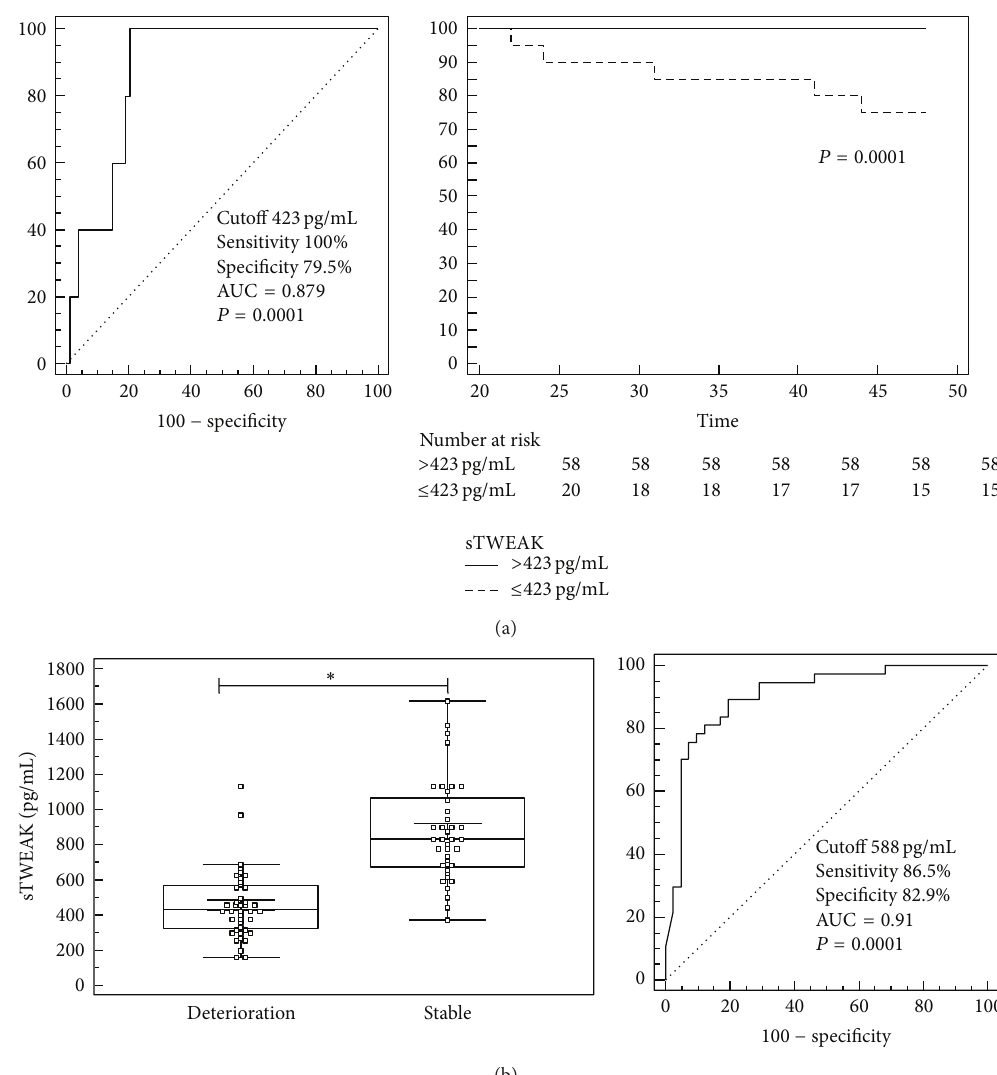
Figure 2: Soluble TWEAK predicts a progressive course of the disease in patients with dilated cardiomyopathy. (a) Receiver operating curve (ROC) analysis of baseline sTWEAK levels in patients with dilated cardiomyopathy revealed a cutoff value of 423 pg/mL for the prediction of death or heart transplantation on serial follow-up. Kaplan-Meier curves differed significantly between patients with a sTWEAK level below 423 pg/mL and those with an above level. (b) In those patients with significant deterioration during serial follow-up ( 𝑛 = 41 ), sTWEAK levels were already significantly reduced during the first visit. ROC analysis revealed a cutoff value of 588 pg/mL for the prediction of progressive symptoms ( ∗ 𝑃 < 0.05